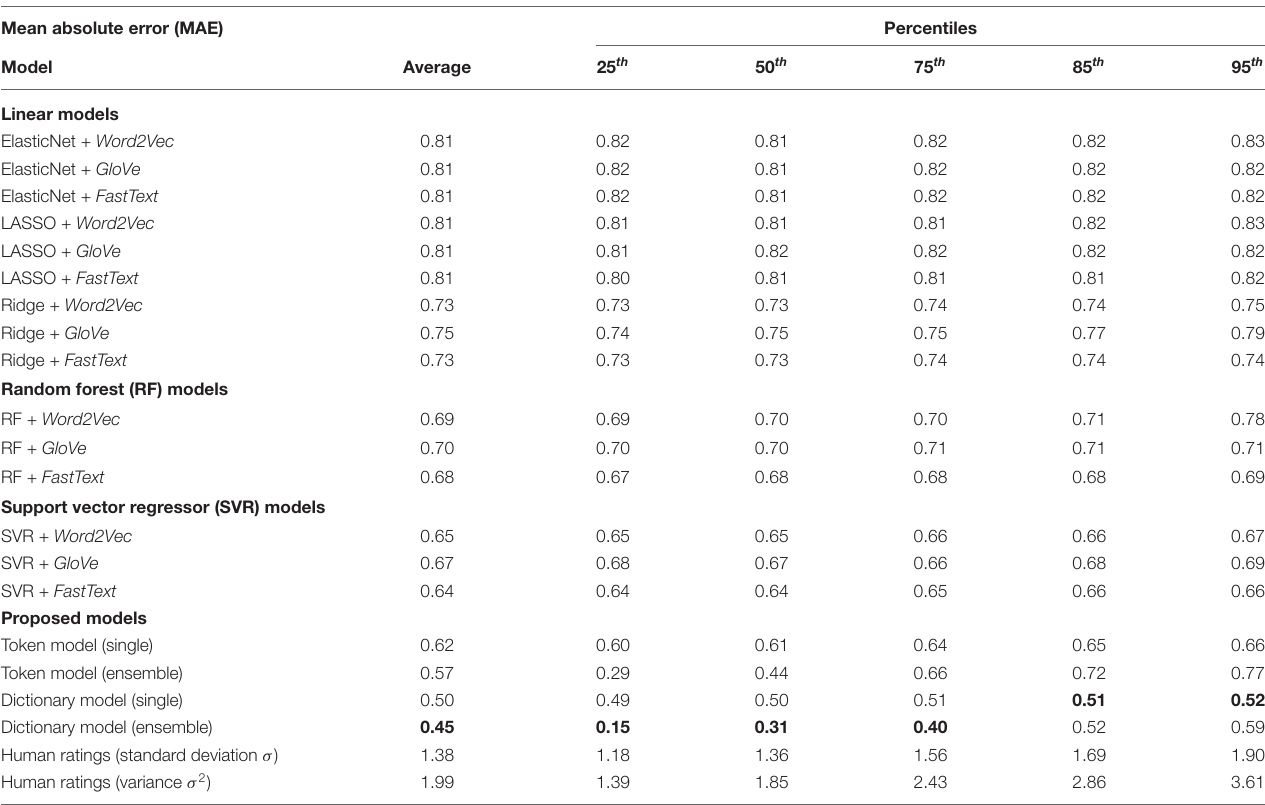
TABLE 1 | Summary statistics of the testing subset comparing our models to the annotated ratings reported in labMT. Mean absolute error